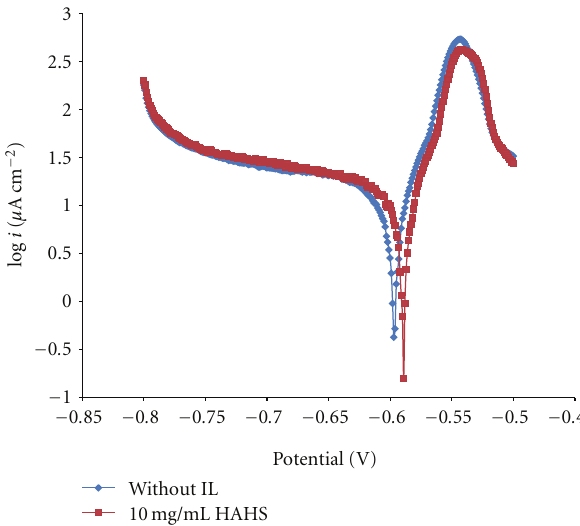
Figure 3: Experimental potentiodynamic polarization curves in the absence and presence of HAHS in 4.0mol · L − 1 H 2 SO 4 at Pb-Sb-Sn alloy. Conditions: Immersion time, 5min; Scan rate, 5mVs − 1